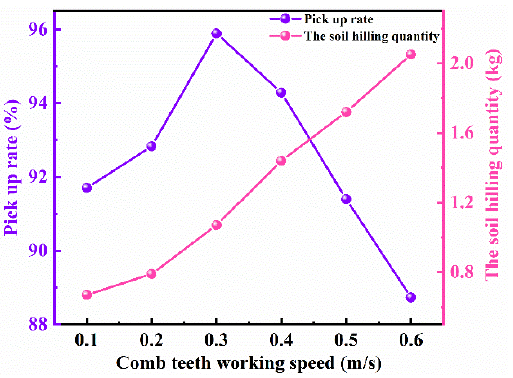
Figure 11. Schematic diagram of the effect of CWS on the test index.